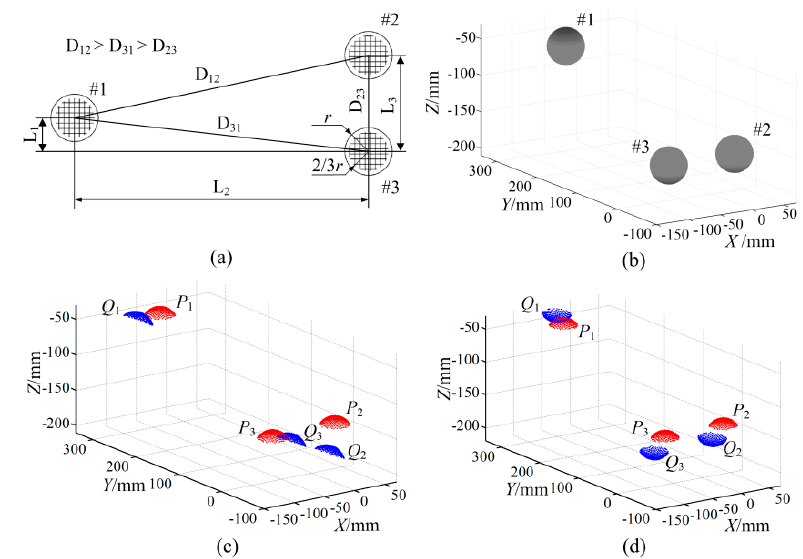
Figure 4. Simulation point clouds of sphere targets, ( a ) the relative positions of the sphere targets; ( b ) simulation sphere surface; ( c ) extracted point clouds with overlapping data; and ( d ) extracted point clouds with non-overlapping